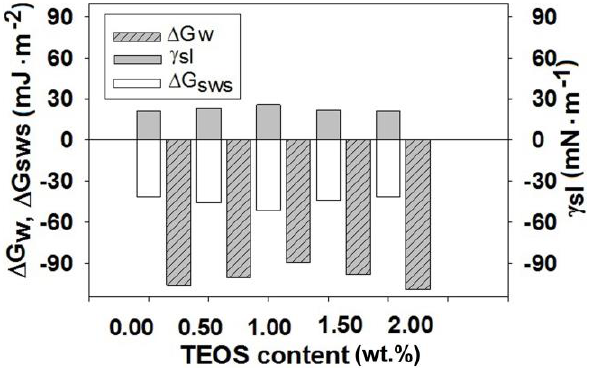
Figure 11. The surface free energy, solid–liquid interfacial tensions, and interfacial free energy versus TEOS content, for cellulose acetate/silica films evaluated taking into account water contact angle.